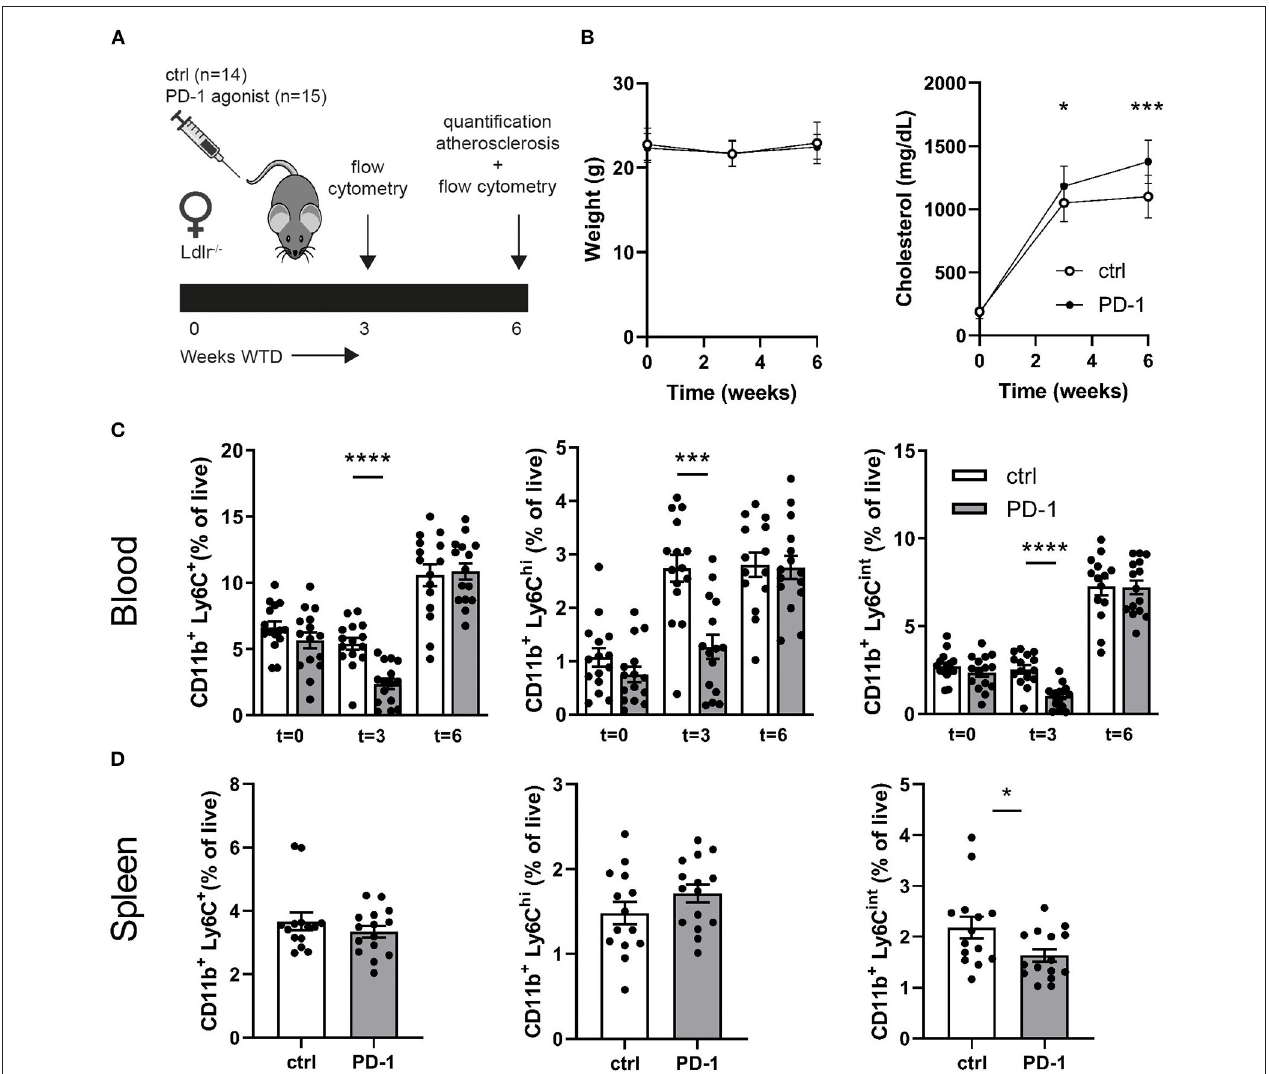
FIGURE 2 | Agonistic PD-1 treatment inhibits WTD-induced increase in circulating monocytes. (A) Experimental setup. Ldlr − / − mice were fed a WTD for 6 weeks while receiving an agonistic PD-1 antibody ( n = 15) or control vehicle ( n = 14). (B) Weight and serum cholesterol levels were assessed before, during and after treatment. Total monocytes (CD11b + Ly6G − Ly6C + ), inflammatory monocytes (CD11b + Ly6G − Ly6C high ) and patrolling monocytes (CD11b + Ly6G − Ly6C int ) were measured by flow cytometry in peripheral blood (C) and spleen (D) . Mean ± SEM are shown. Statistics was performed using unpaired T -test. P ≤ 0.05 are considered significant. * p ≤ 0.05, *** p ≤ 0.001, **** p ≤